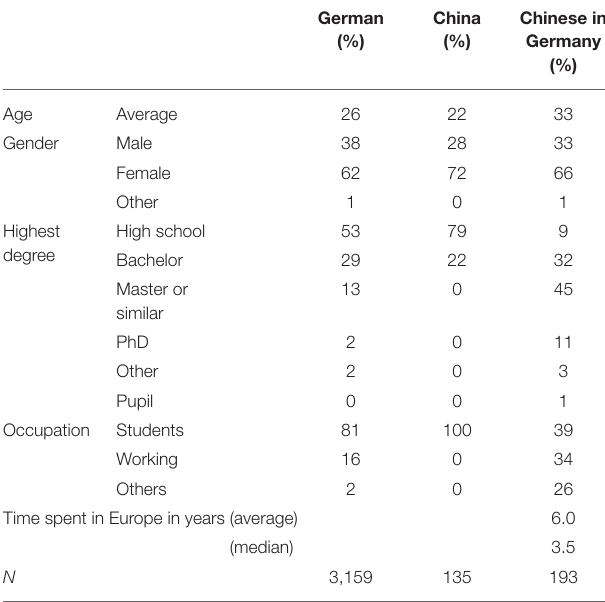
TABLE 1 | Demographic characteristics of the three samples. TABLE 2 | Correlation between patriotism, uncritical patriotism, and various COVID-19-related beliefs among German students.